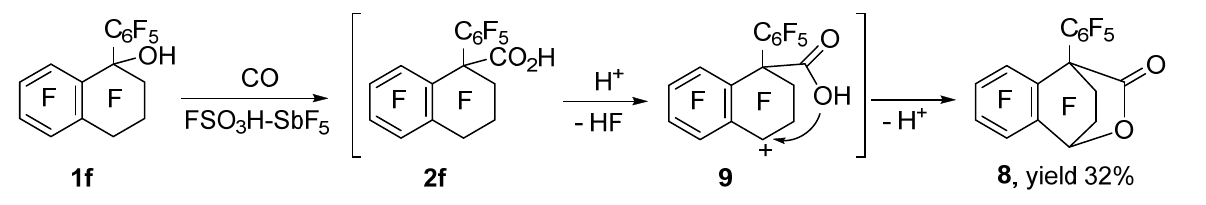
Scheme 1. Transformations of compound 1d in the reaction with CO in TfOH–SbF 5 followed by water